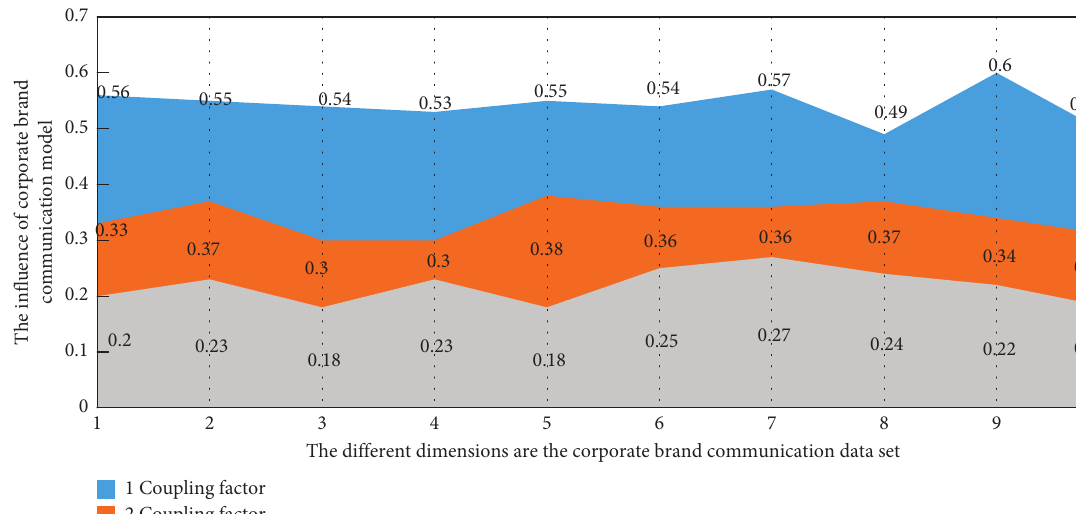
Figure 4: The simulation results of PSO algorithm for optimization analysis and solution of 10 groups of data with different dimensions.